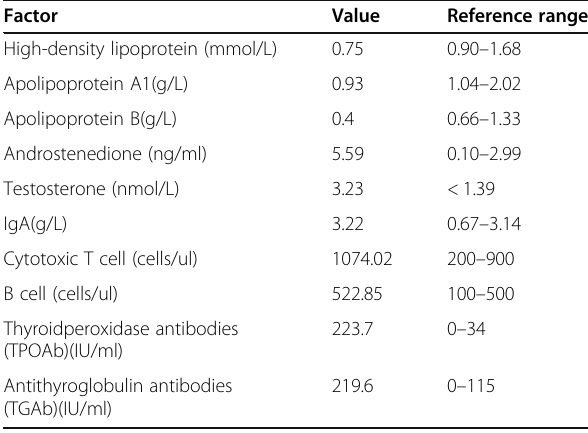
Table 1 Laboratory results of the patient